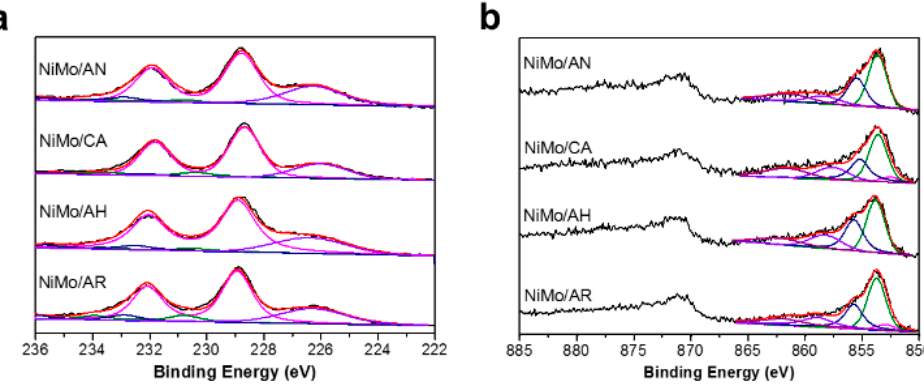
Figure 4. Mo 3d ( a ) and Ni 2p ( b ) XPS spectra of the alumina supported NiMoS Table 2. Fractions of Mo species in the sulfided catalysts by XPS analysis.